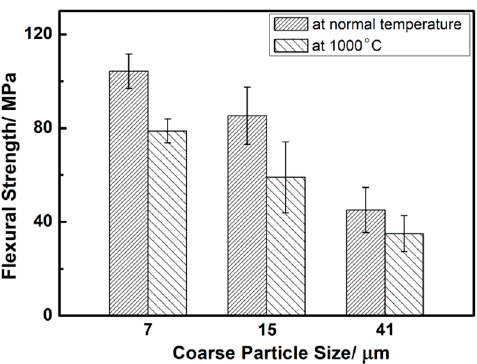
Figure 4. Three-point flexural strengths of porous L-SiC ceramics with different particle sizes of the initial coarse SiC powder at normal temperature and 1000 °C.